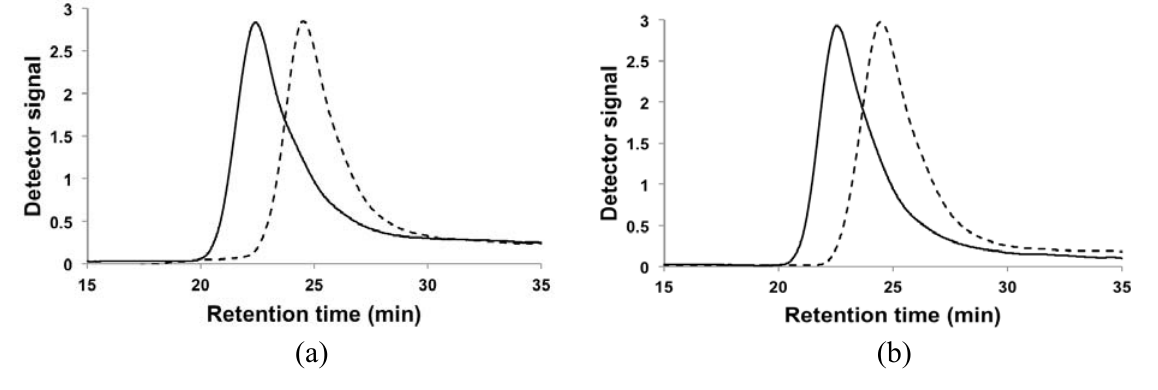
= 95 mol% DMAEMA = 90 DMAEMA